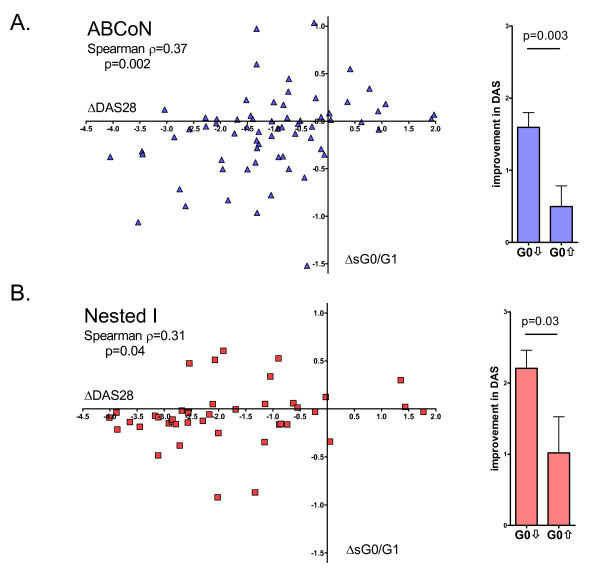
Correlation between changes in ratio of agalactosylated to monogalactosylated N-glycans in serum (sG0/G1) and 28-joint Disease Activity Score utilizing C-reactive peptide. Differences reported are between baseline and 3-month visits. Each point represents an individual patient. Plots at right depict improvement (decrease) in Disease Activity Score (DAS) comparing patients in whom the sG0/G1 either increased or decreased appreciably (> 0.1 U) over the interval studied. (A) Autoimmune Biomarkers Collaborative Network (ABCoN). (B) Nested I.